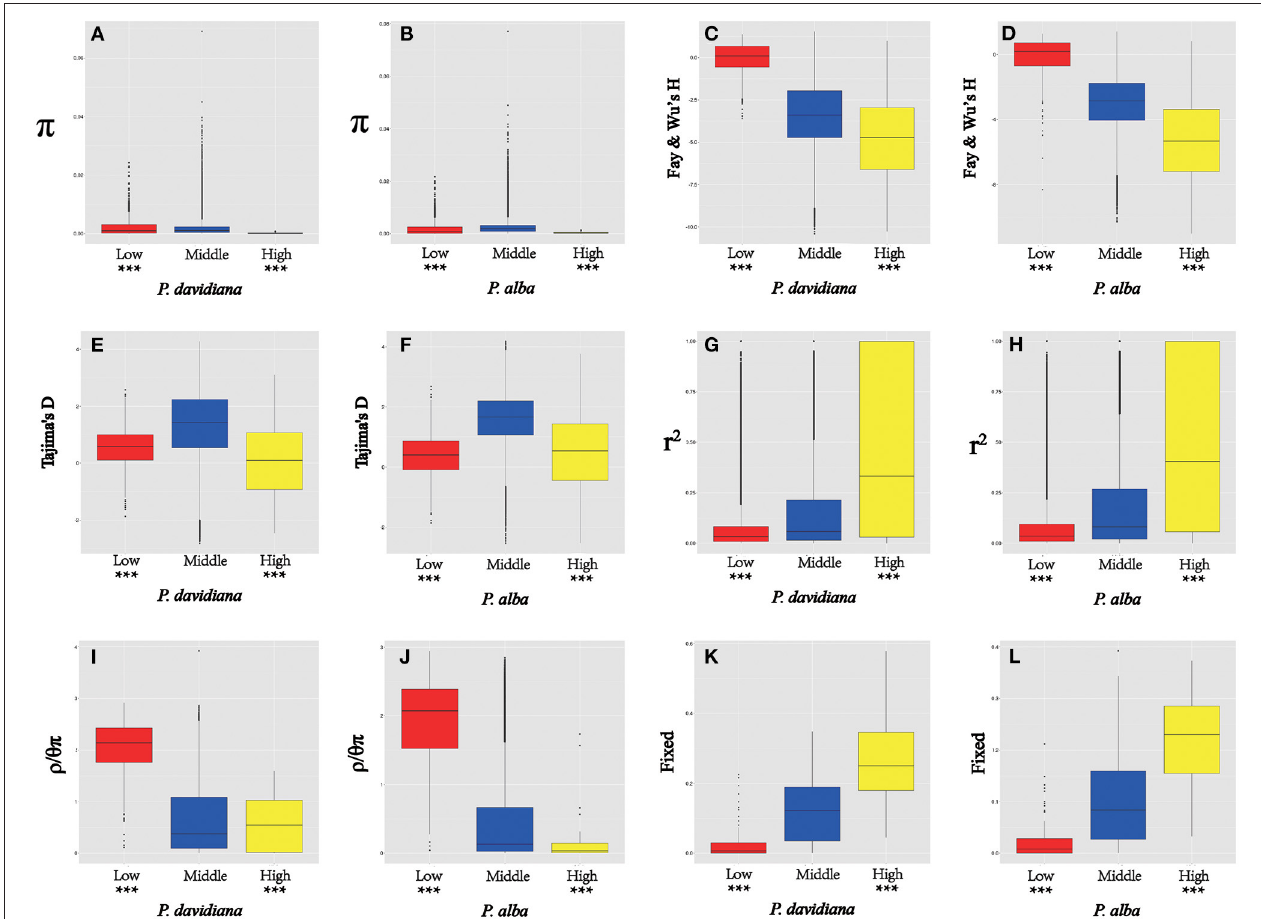
FIGURE 5 | The outlier regions are significantly influenced by natural selection. (A,B) Comparisons of nucleotide diversity π among regions displaying significantly high (yellow boxes) and low (red boxes) differentiation vs. the genomic background (blue boxes) between P. davidiana and P. alba .; (C,D) Comparisons of Fay & Wu’s H in P. davidiana and P. alba ; (E,F) Comparisons of Tajima’s D in P. davidiana and P. alba ; (G,H) Comparisons of r 2 in P. davidiana and P. alba ; (I,J) Comparisons of recombination rate ( ρ / θπ ) in P. davidiana and P. alba ; (K,L) Comparisons of the proportion of fixed differences caused by derived alleles fixed in P. davidiana and P. alba . Asterisks designate significant differences between outlier windows and the rest of genomic regions by Mann-Whitney U test (*** P <